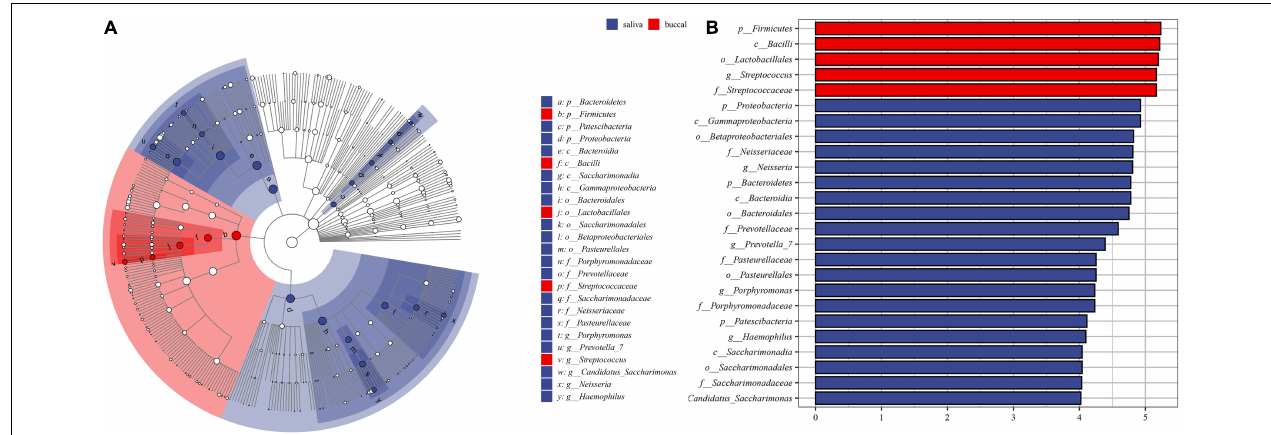
FIGURE 2 | The results of Linear discriminant analysis effect size (LEfSe). (A) The cladogram of taxa showed significant differences between saliva and buccal mucosa. (B) The bar graph of LDA scores showed the taxa with statistics differences between the two groups. The LDA threshold was 4.